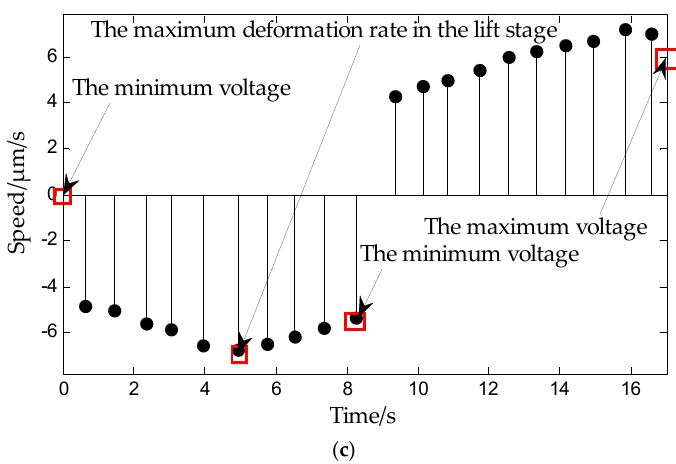
Figure 7. Deformation rate of piezoelectric actuators for an applied voltage of 150 V with frequency 1 Hz in ( a ) triangular wave form; ( b ) sign-wave form, u = 150(sin π t /5) positive half cycle; ( c ) Manually added, 0 V–150 V–0 V, at steps of 15 V. Below the timeline, the voltage is loaded from the minimum voltage (0 V) to the maximum voltage (150 V). Above the timeline, the voltage drops from the maximum voltage (150 V) to the minimum voltage (0 V).